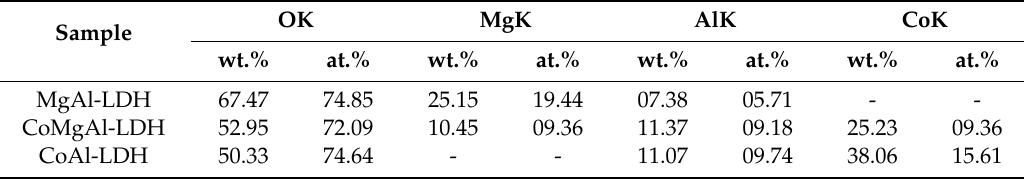
Table 1. Data obtained from EDS analysis for all the investigated samples.